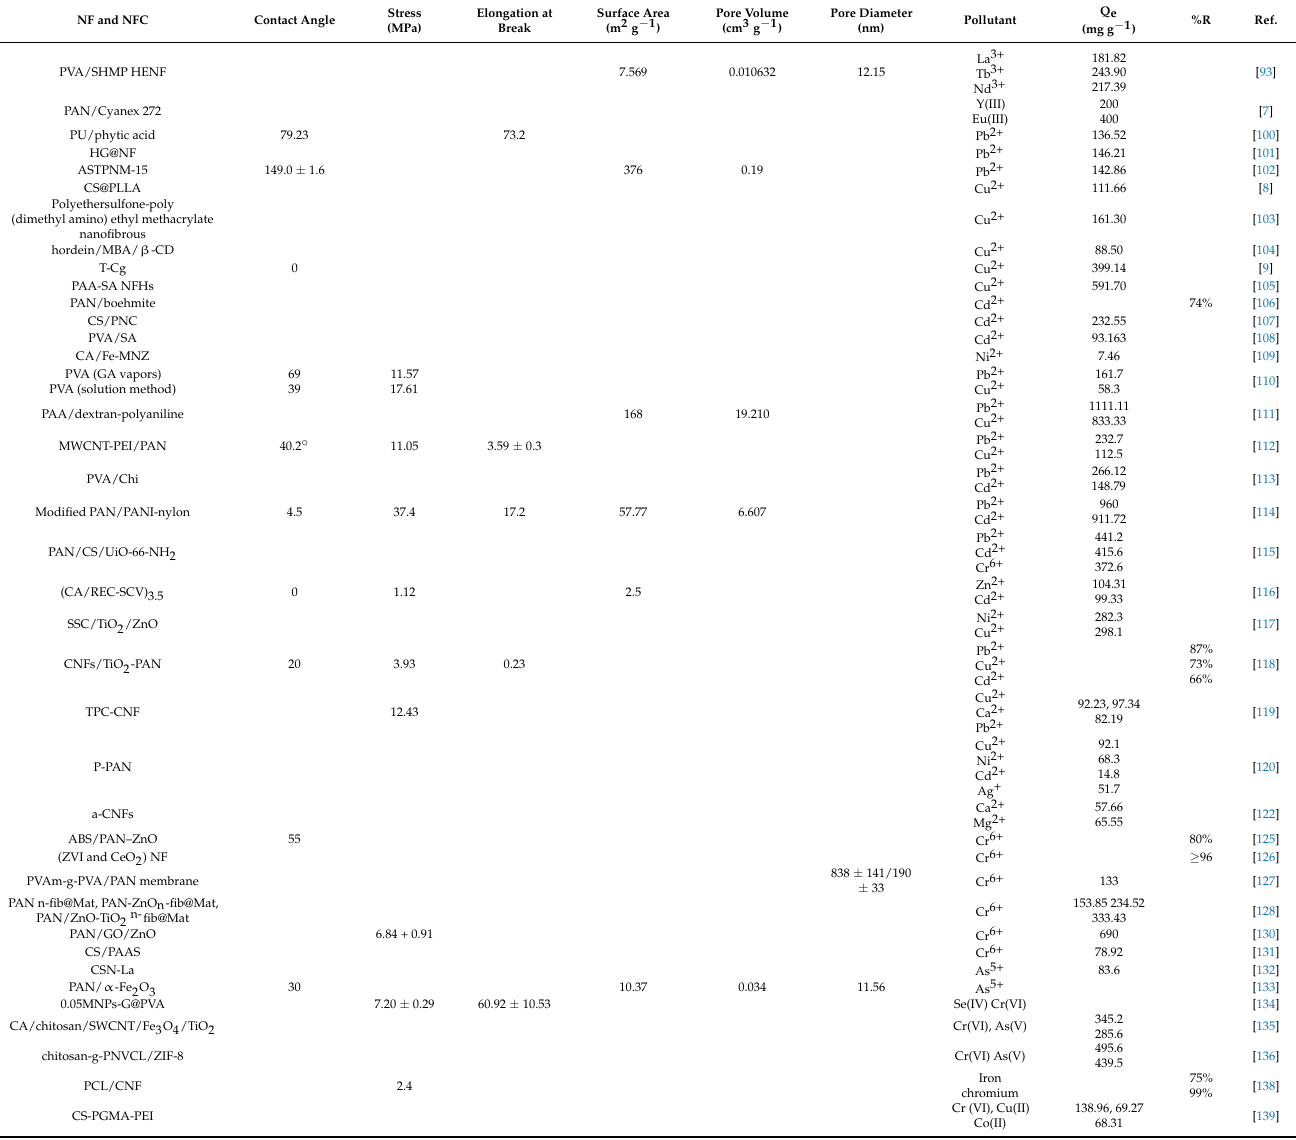
Table 2. Summary of optimum conditions for nanofibres used in the removal of inorganic